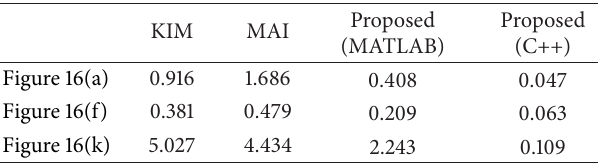
Table 1: Time requirement of each method to process the real images